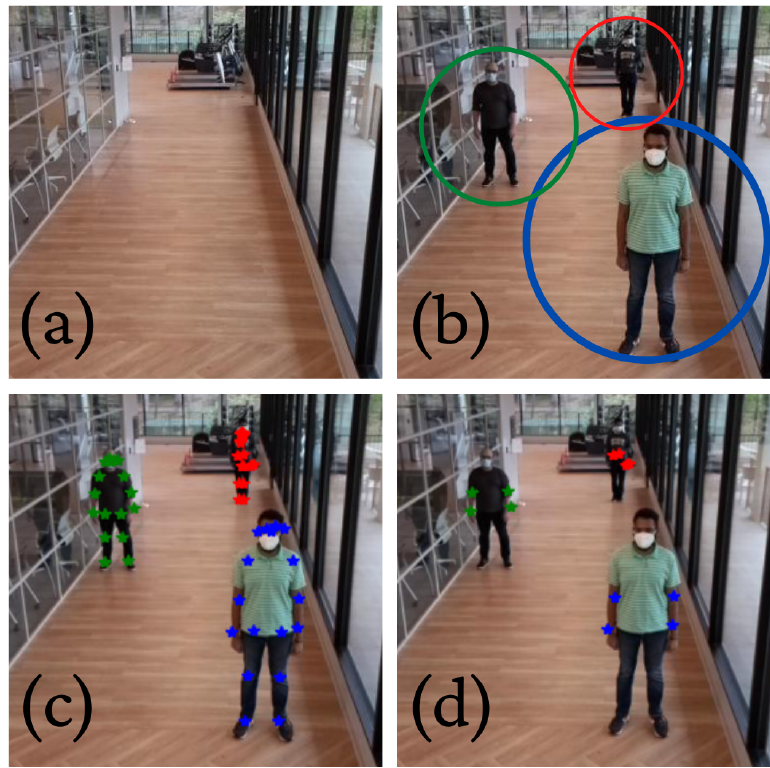
Figure 2. PoseNet [75] for human pose detection. ( a ) We show the scene without any humans. ( b ) The scene with three humans standing. ( c ) The identified keypoints using PoseNet have been overlaid on the individual humans. ( d ) The keypoints corresponding to the elbows and wrists have been retained. This is useful for analyzing hand